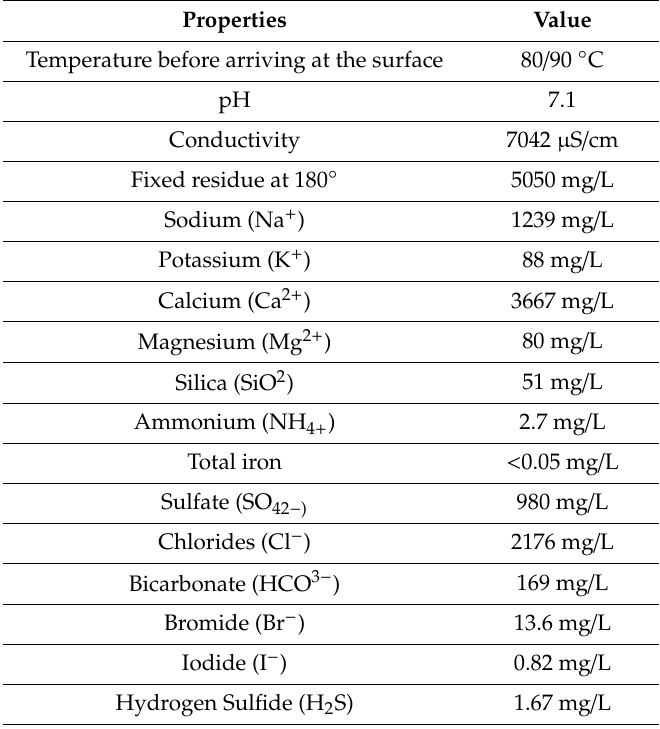
Table 1. Euganean Hill thermal basin chemical–physical water